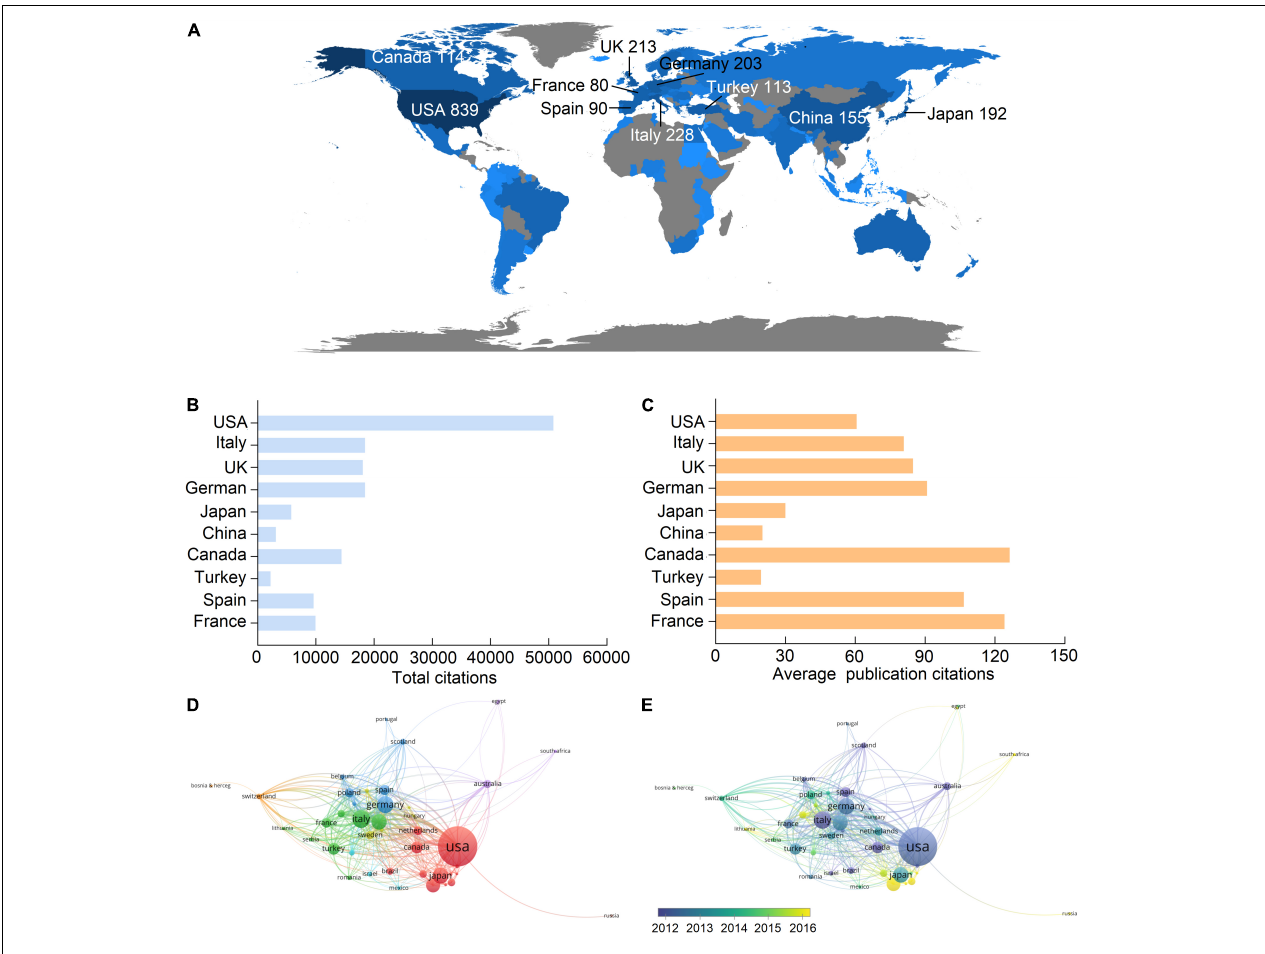
FIGURE 2 | Leading countries in the uremic cardiomyopathy field. (A) Worldwide distribution of the publication. (B,C) Total citations and average publication citations of the top 10 productive countries. (D) Clustering of collaboration among countries. (E) Timeline visualization of collaboration among countries.